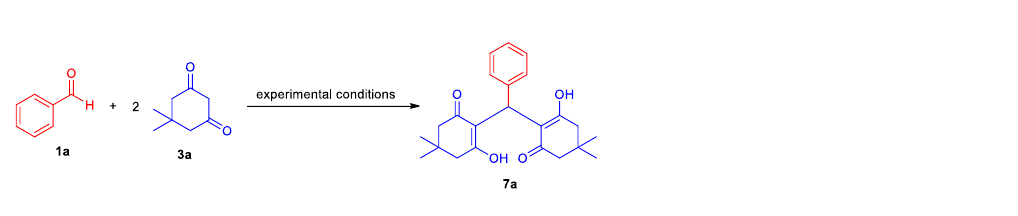
Figure 7. Model reaction for optimization